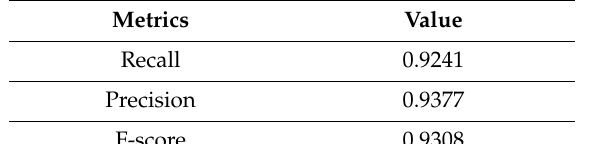
Table 2. Statistics of VPARS flood mapping validation.